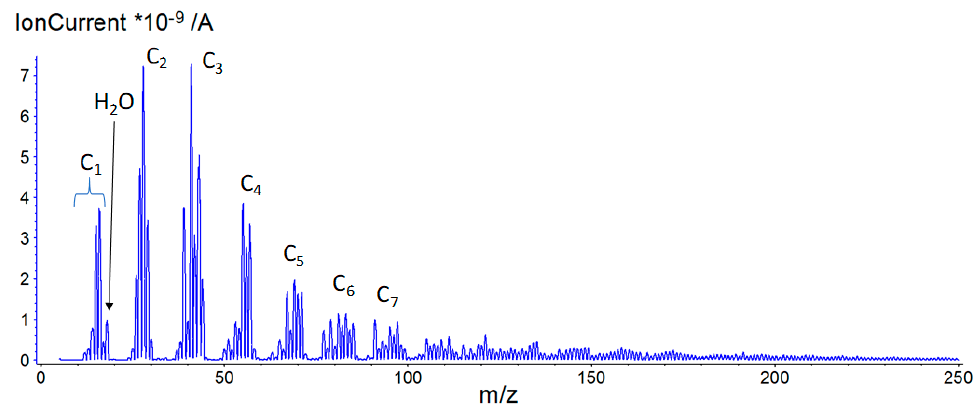
Figure 10. Mass spectrum recorded during thermogravimetric analysis of Piceance Basin shale under dry helium (curve D of Figure 9). The spectrum was recorded during the mass loss step at 466 °C (Figure 9).